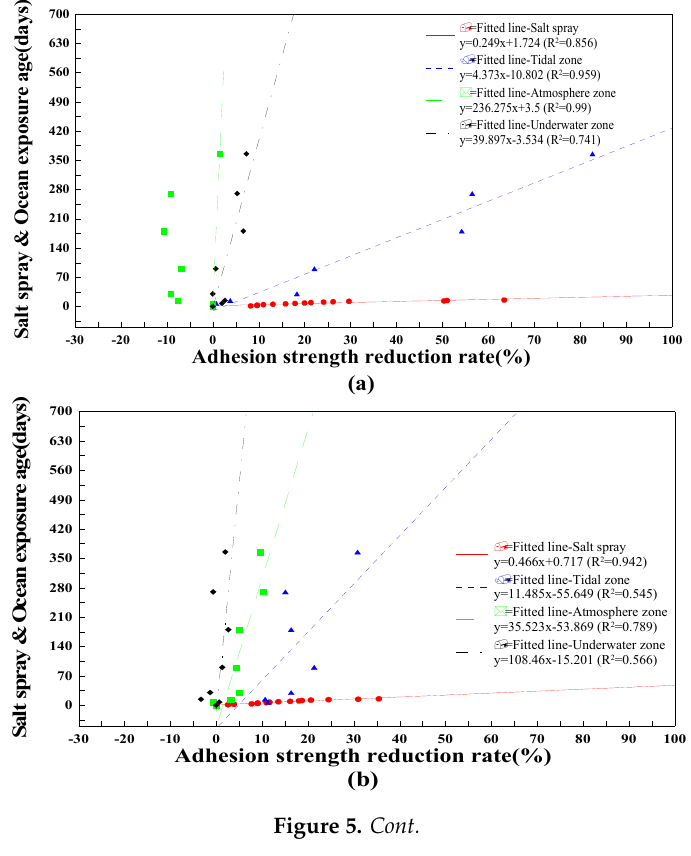
 =Fitted line-Tidal zone y=4.373x-10.802 (R 2 =0.959)  =Fitted line-Atmosphere zone y=236.275x+3.5 (R 2 =0.99)